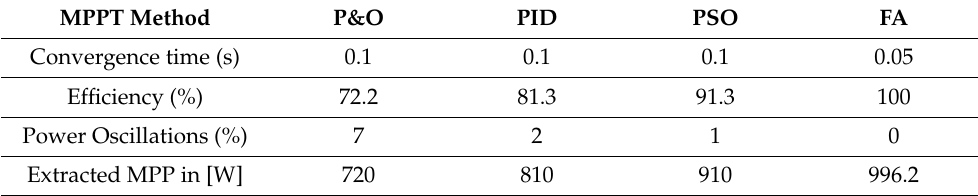
Table 5. Performance comparison of FA, P&O, PID and PSO (Case 1).